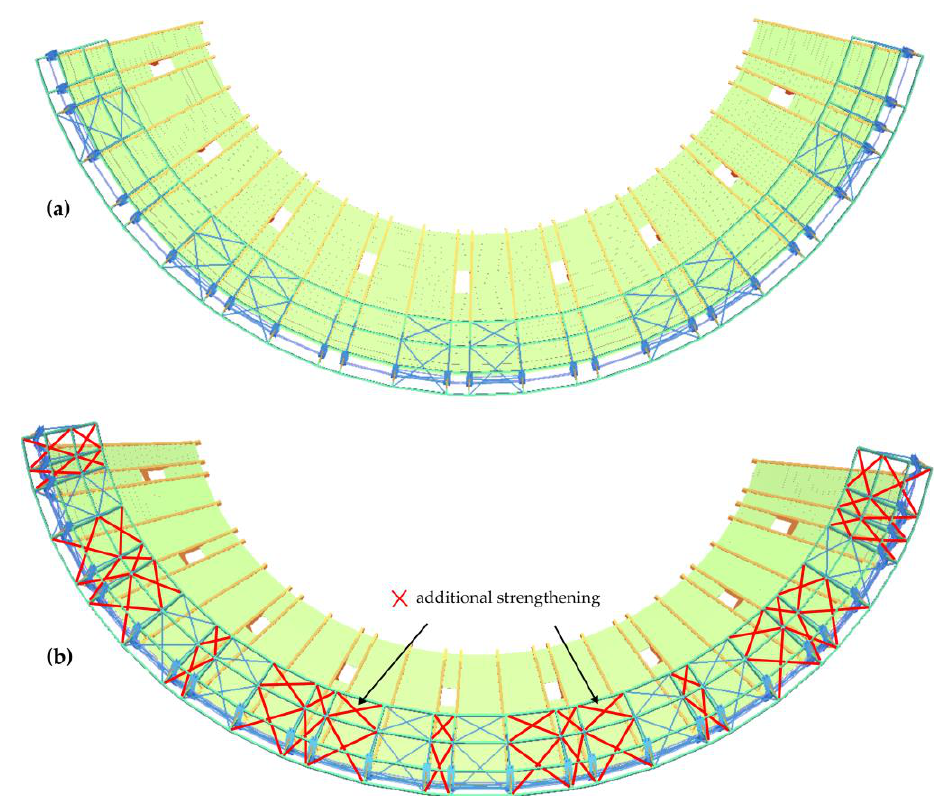
Figure 23. Additional roof bracings ( a ) before structural tuning, ( b ) after structural tuning .